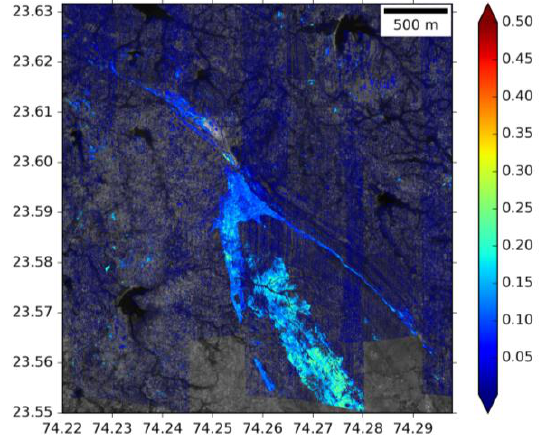
Figure 2. Band depth of the deepest absorption feature in SWIR region. Areas with low band depth values (<0.03) indicate residual atmospheric and sensor artefacts and are masked